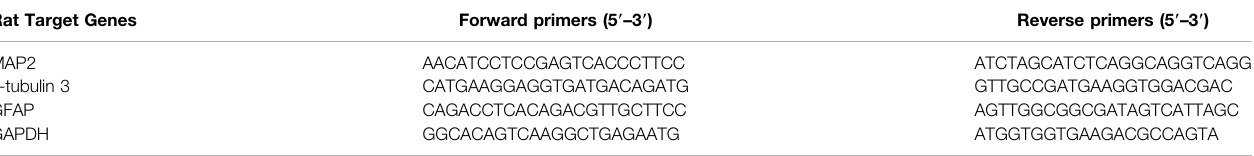
TABLE 1 | The primer sequences for quantitative reverse transcription-polymerase chain reaction. Rat Target